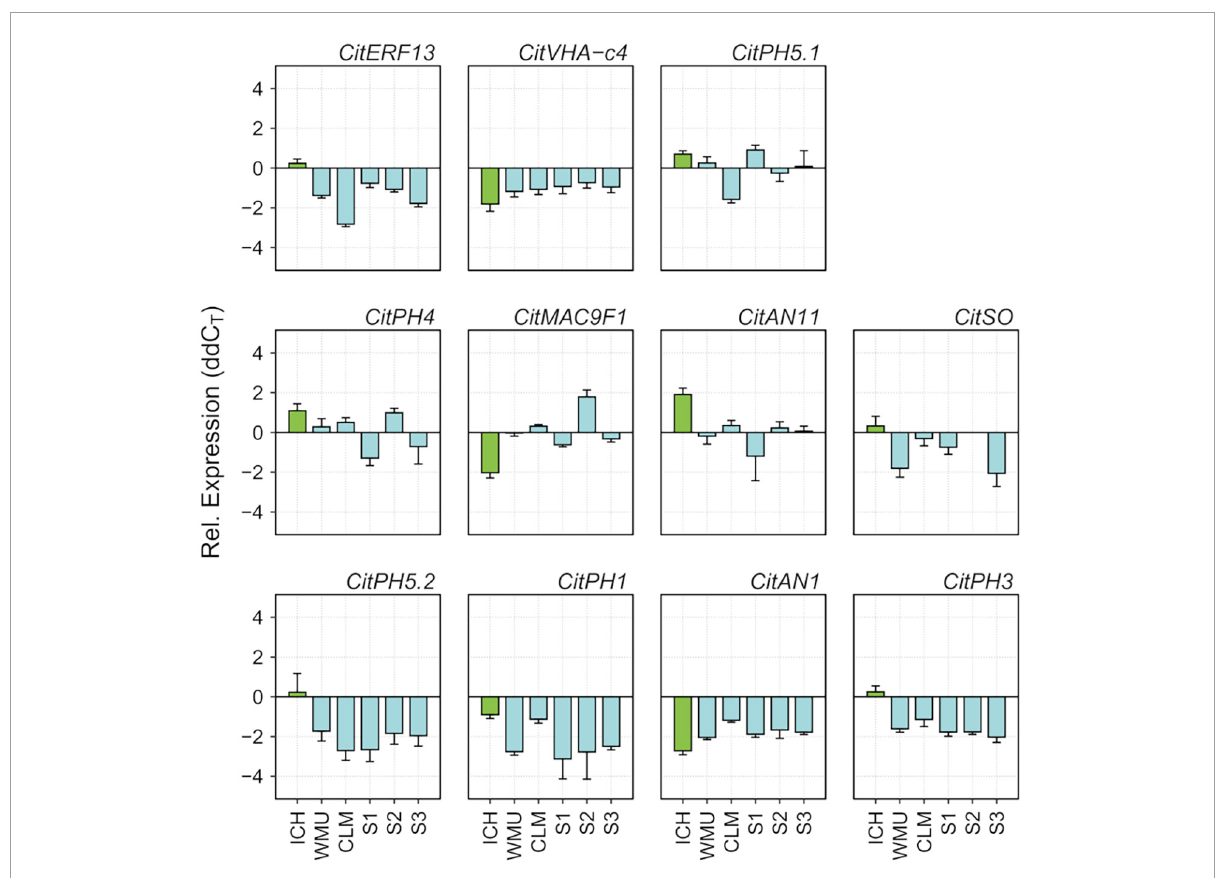
FIGURE3 Relative expression of genes reported to be involved in acid regulation of citrus fruits (Aprile et al., 2011; Butelli et al., 2019; Strazzer et al., 2019; Huang et al., 2021), determined by RT-qPCR in juice vesicles of ripening fruits (November) of ICH, SCM, WMU, CLM and S1, S2, and S3 segregants. Vertical bars represent standard error from two technical